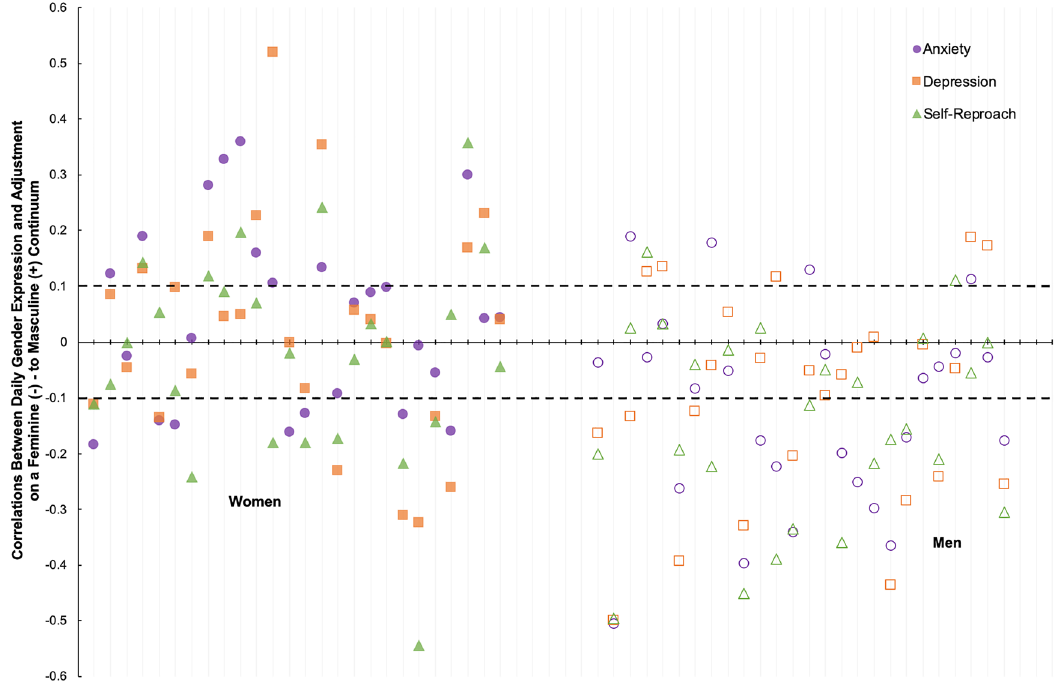
Figure 2. Scatterplot of person-specific correlations (residuals from first order autocorrelations) between daily gender expression (feminine-to-masculine continuum) and three indices of daily psychological adjustment: anxiety (purple circles), depression (orange squares), and self-reproach (green triangles). The y-axis depicts the strength of the correlations, and the x-axis depicts individual participants, with women (solid points) on the left and men (open points) on the right. Thick dashed lines at r = 0.10 and r = −0.10 demarcate a small effect size (Cohen, 1988), with correlations above and below the lines, respectively, reflecting meaningful individual-level